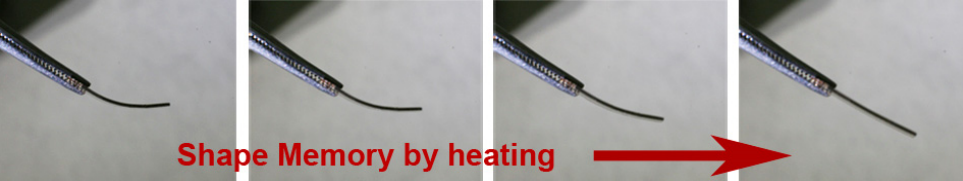
Figure 15. Images showing the shape memory effect obtained in the LPBF single melt sample after HIP and TT–0 thermal treatment. The sample, 14 mm long, was deformed at room temperature, so in martensite, and heated with a hair dryer to recover the shape in austenite.